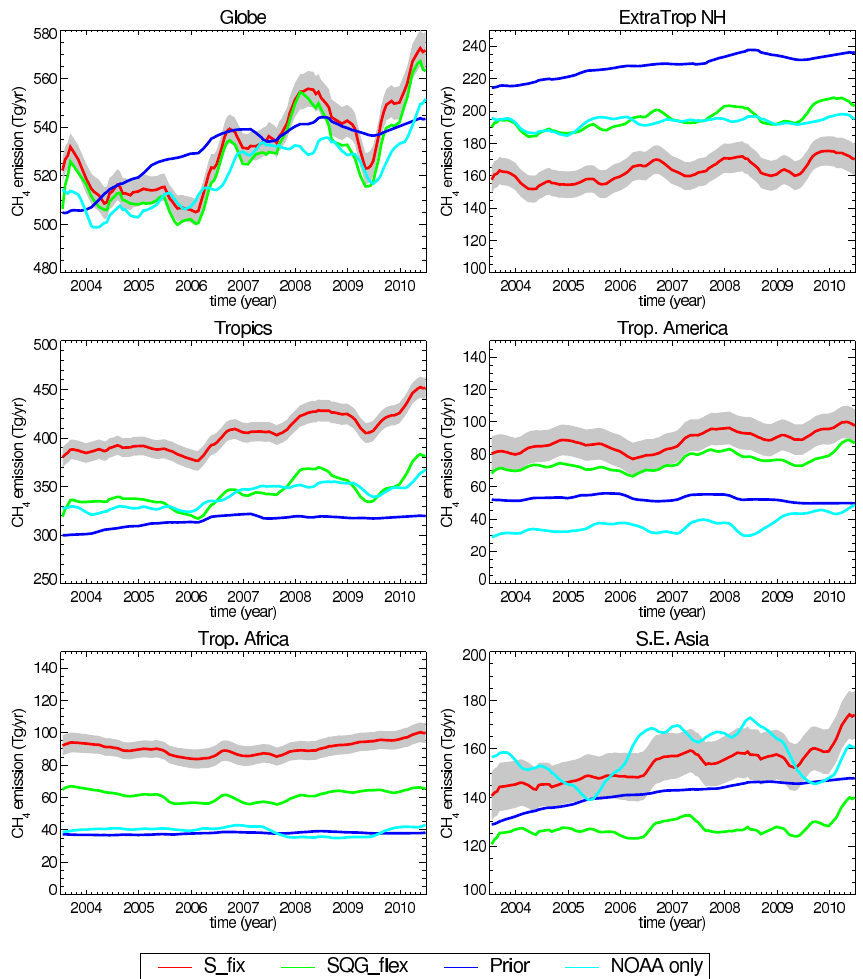
Fig. 10. Inter-annual variability of inversion derived CH 4 fl uxes integrated over large regions. Dark blue: A priori fl ux, Light blue: NOAA only, Red: S fix + 2 σ posterior uncertainty, Green: SQG flex . For the region de fi nition see Figure 1.